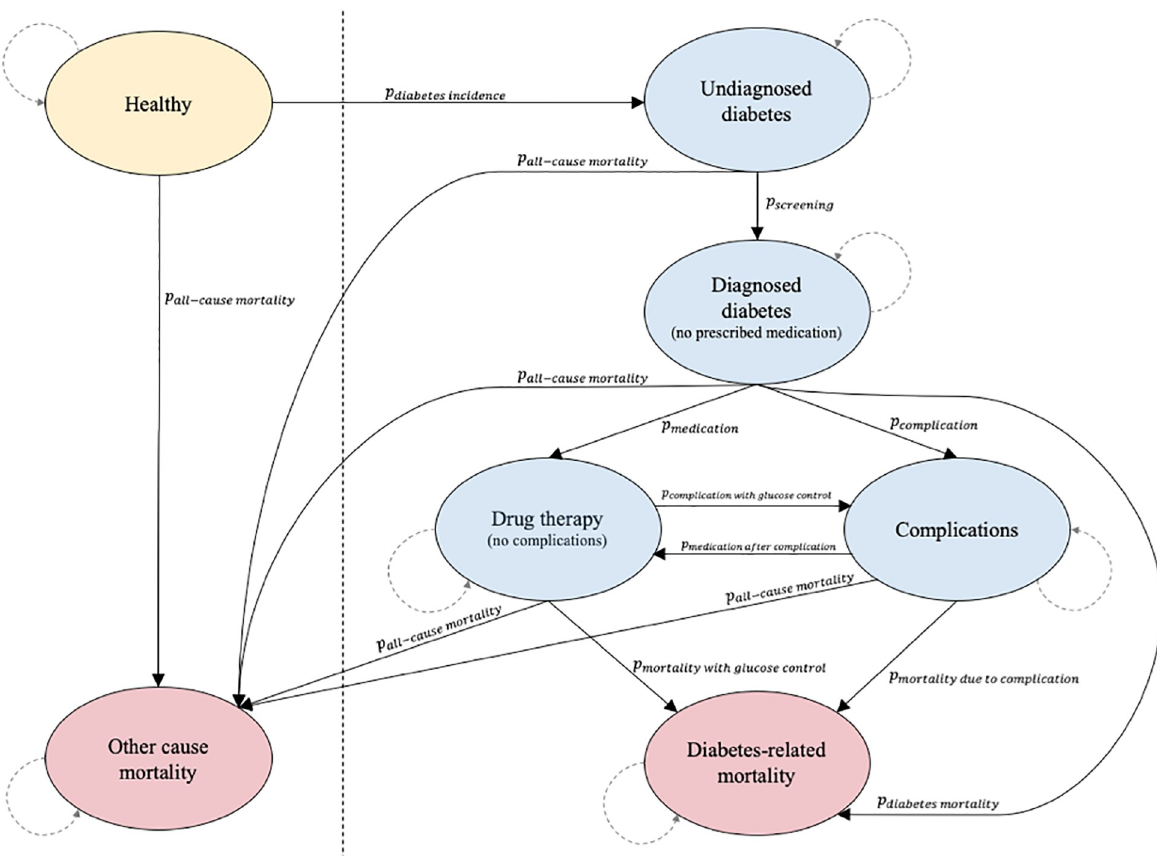
Fig 1. Representation of the Markov model integrating disease and care delivery states. ‘Drug therapy’ state includes oral anti-diabetic drug therapy and insulin therapy options. ‘Complications’ state entails incidence of major complications and subsequent treatment.